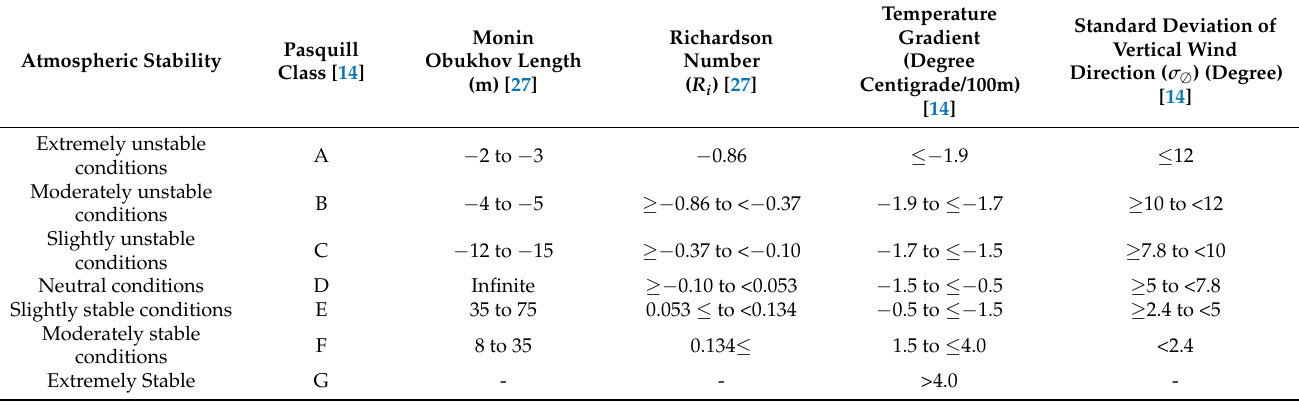
Table 2. Typical values of five stability indicators under different atmospheric